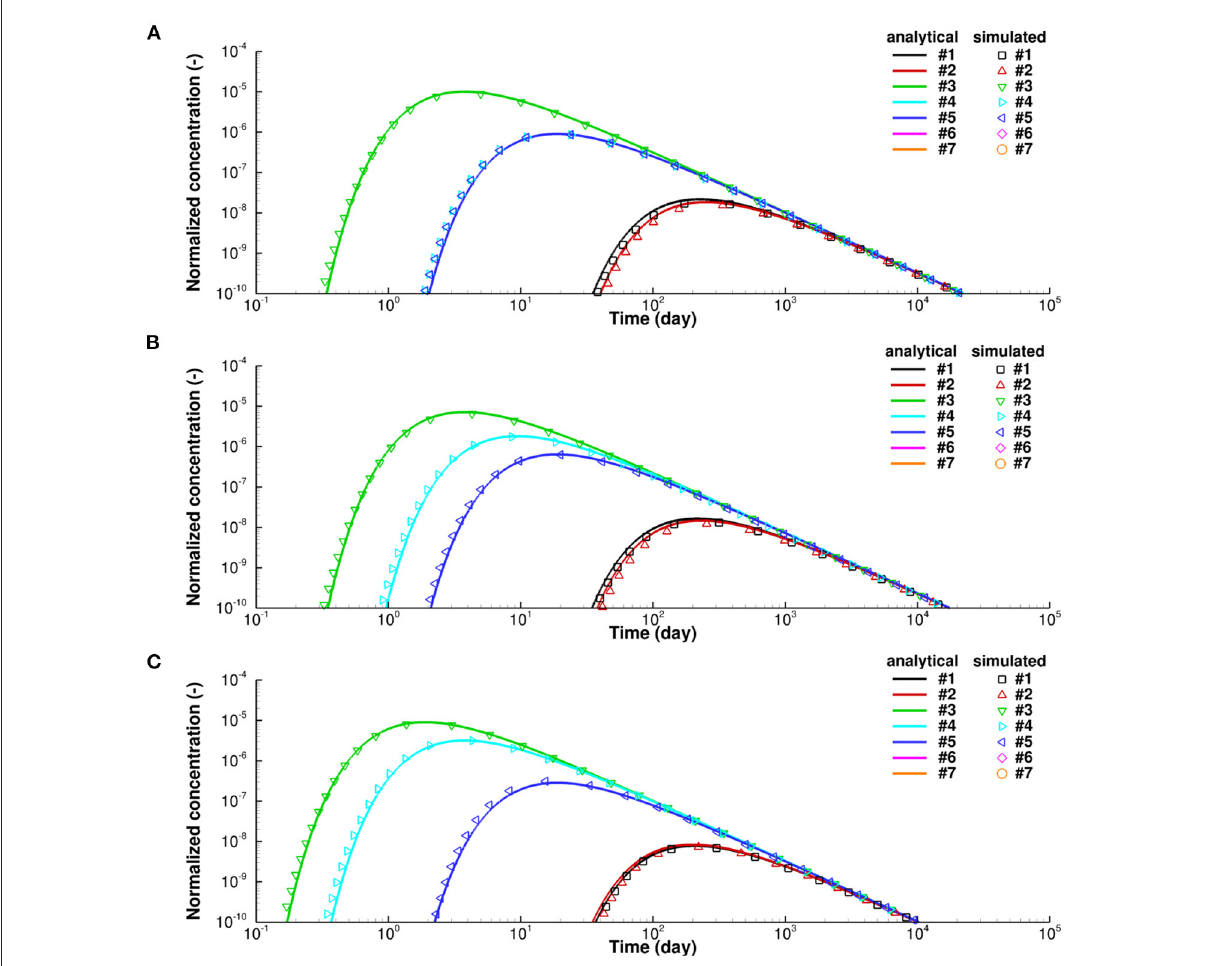
FIGURE4 Normalized concentration changes over time at specified observation points for 3D anisotropic diffusion verification problem, (A) with anisotropy ratio τ